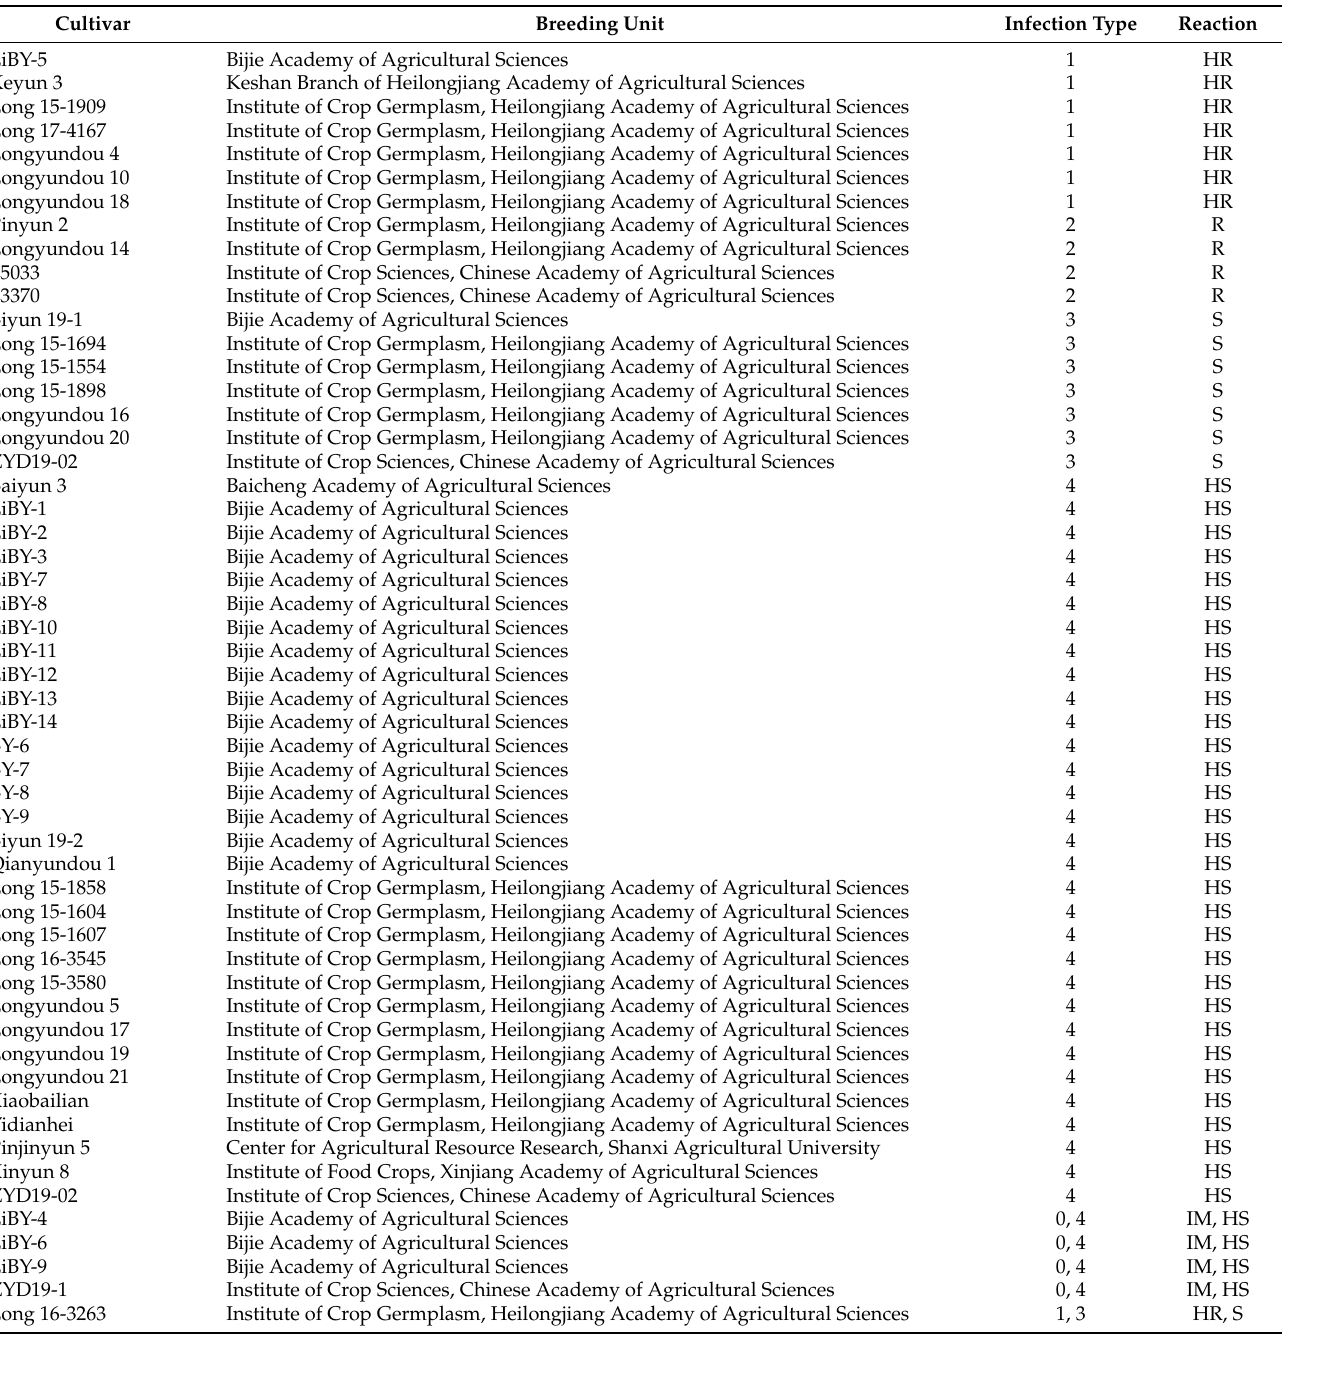
Table 3. Identification of resistance to powdery mildew on common bean cultivars. Cultivar Breeding Unit Infection Type